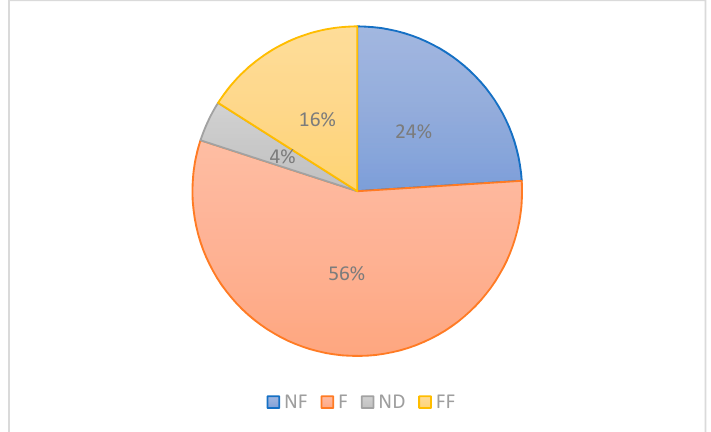
Figure 6. Results of the experiments in the first period after lunch for the morning circadian chrono-type.